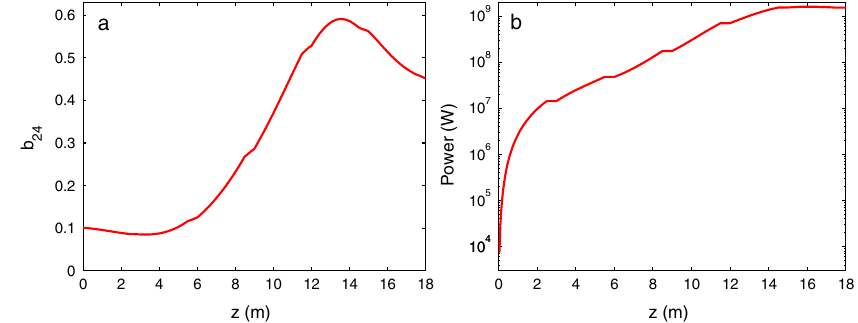
FIG. 10. (Color) (a) Bunching factor vs radiator distance for the 10 nm radiation. (b) Peak power vs radiator distance for the 10 nm